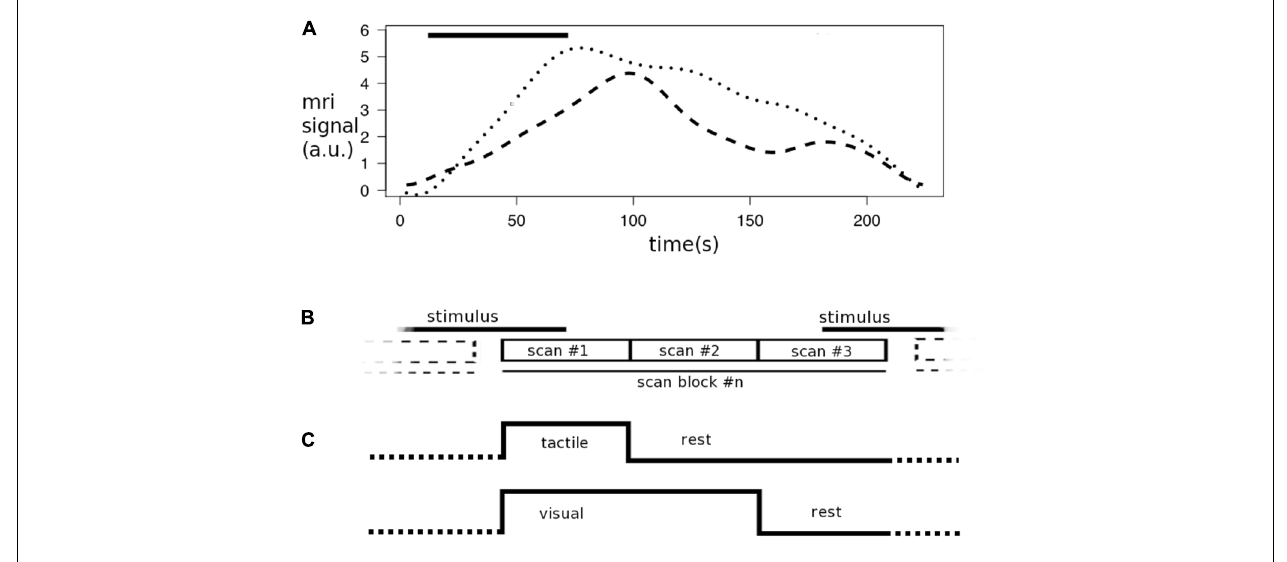
the tactile stimulus (bar) falls within the first scan of a scan block while the maximum of the response function (dashed line) of the visual stimulus is found between the first and second scan. (C) Therefore in the fDTI experiment the tactile task the first scan is contrasted against the second and third scan, while for the visual task the first and second scan are contrasted against the third scan.The signal during the stimulus is constantly increasing (reflecting a reduction in diffusivity in the transverse direction of the tract).